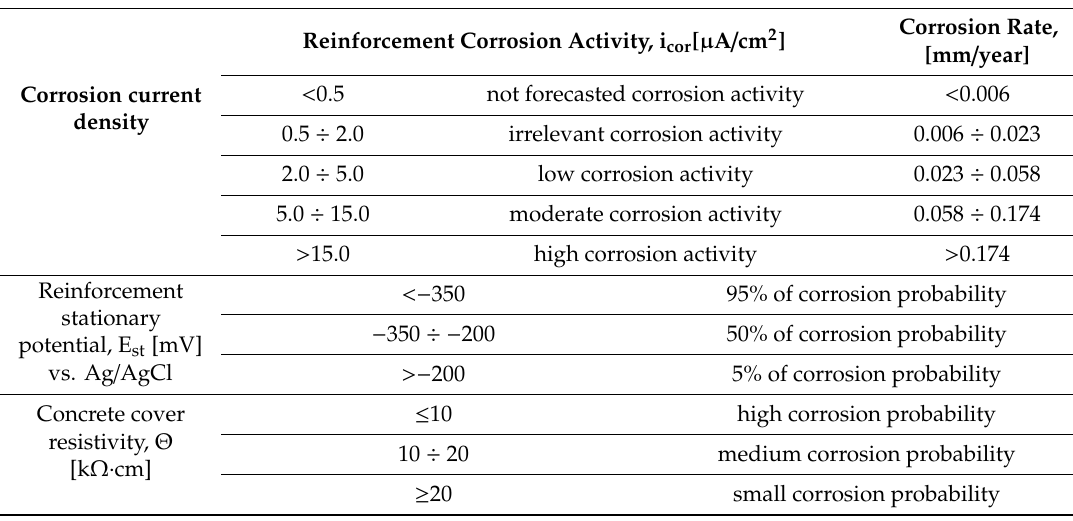
Table 1. Criteria for assessing the reinforcement corrosion risk level [32].